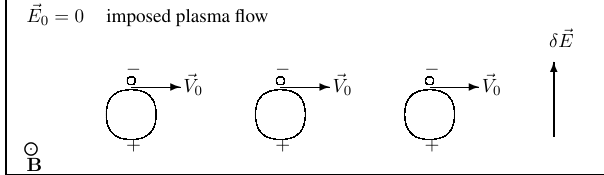
Fig. 2. Sketch of trajectories and charge locations for initially im- posed plasma flow with no electric field. + − indicate charge separation resulting from the gyromotion, with δ E the associated electric field. The trajectories are drawn for the limit | δ E | (cid:28) | V × B /c | ; see text for discussion of the more general 0